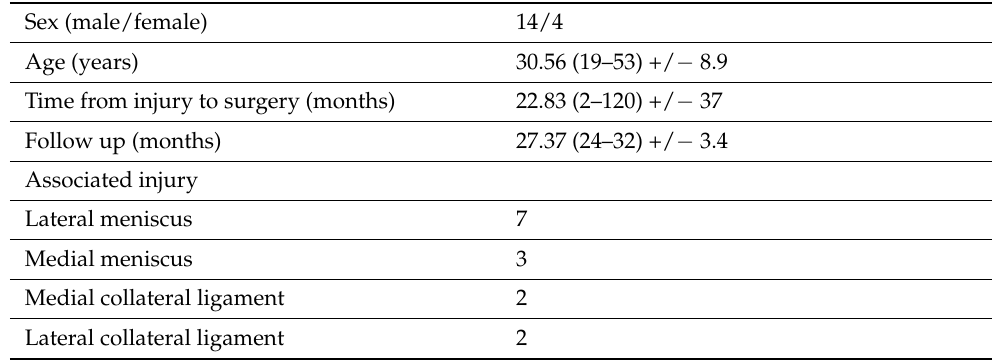
Table 1. General data and associated injury.